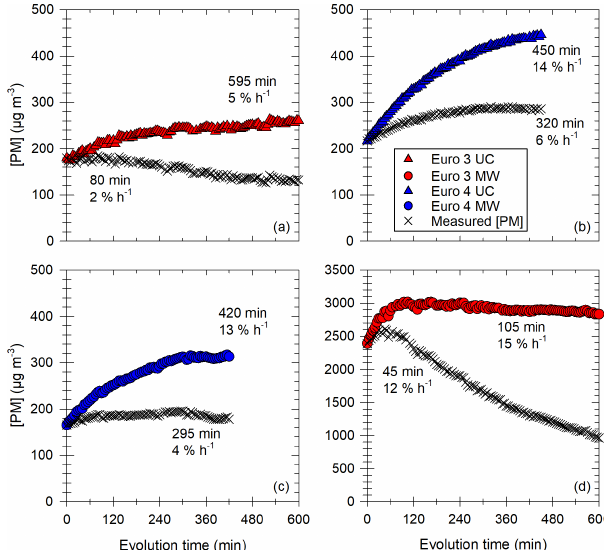
Figure F1. Evolution of the corrected PM concentrations for the Euro 3 vehicle (red) and Euro 4 vehicle (blue) under both UC (trian- gles) and MW (circles) conditions. Panels (a) , (b) and (c) represent long increases, whereas panel (d) represents a short increase. The corrected concentrations are compared to the measured (e.g., un- corrected) PM concentrations (black crosses). Labels give for each evolution (measured or corrected) the time at which [PM] reaches its maximum as well as the associated hourly